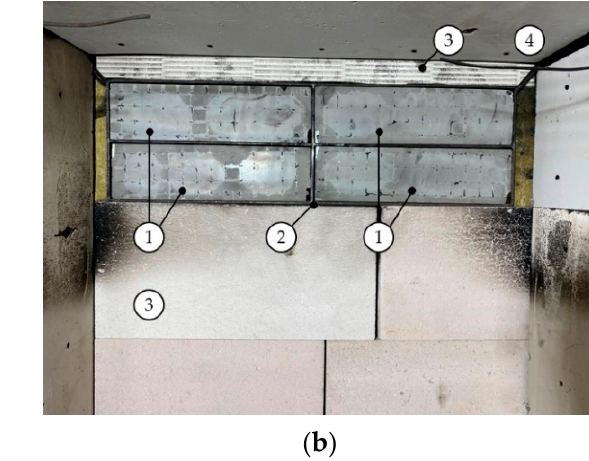
Figure 4. Scheme of the position of the test specimens: ( a ) side view on the specimen placements; ( b ) view from inside the furnace of the placed test specimens Legend: 1—exposed side of the test specimen; 2—steel construction holding test specimens; 3—furnace front wall from aerated concrete blocks thickness 100 mm; 4—ceiling of the